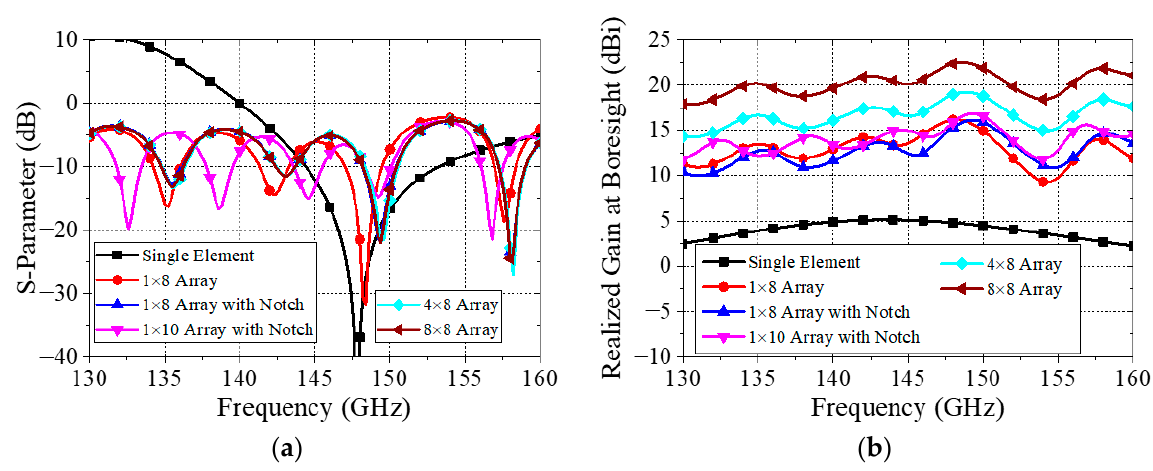
Figure 5. ( a ) S-parameter and ( b ) realized gain at boresight of a single patch element, the one-by- eight array, the one-by-eight array with the inset feed, and the final eight-by-eight array.